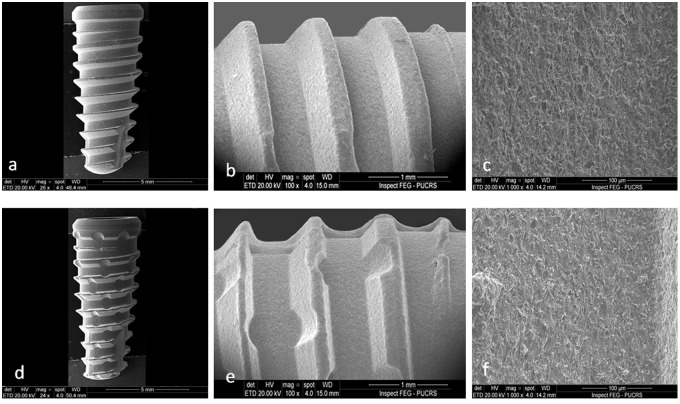
Sequence of SEM images of the two implant macrogeometries used.(a-c) implant of the CON group and (d-f) implant of the new macrogeometry of the TEST group.